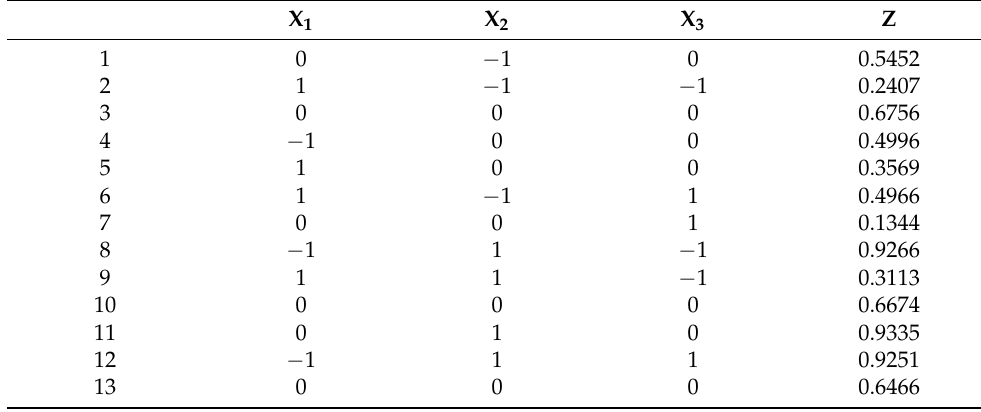
Table 4. Each factor level and Z value in central composite design (CCD)